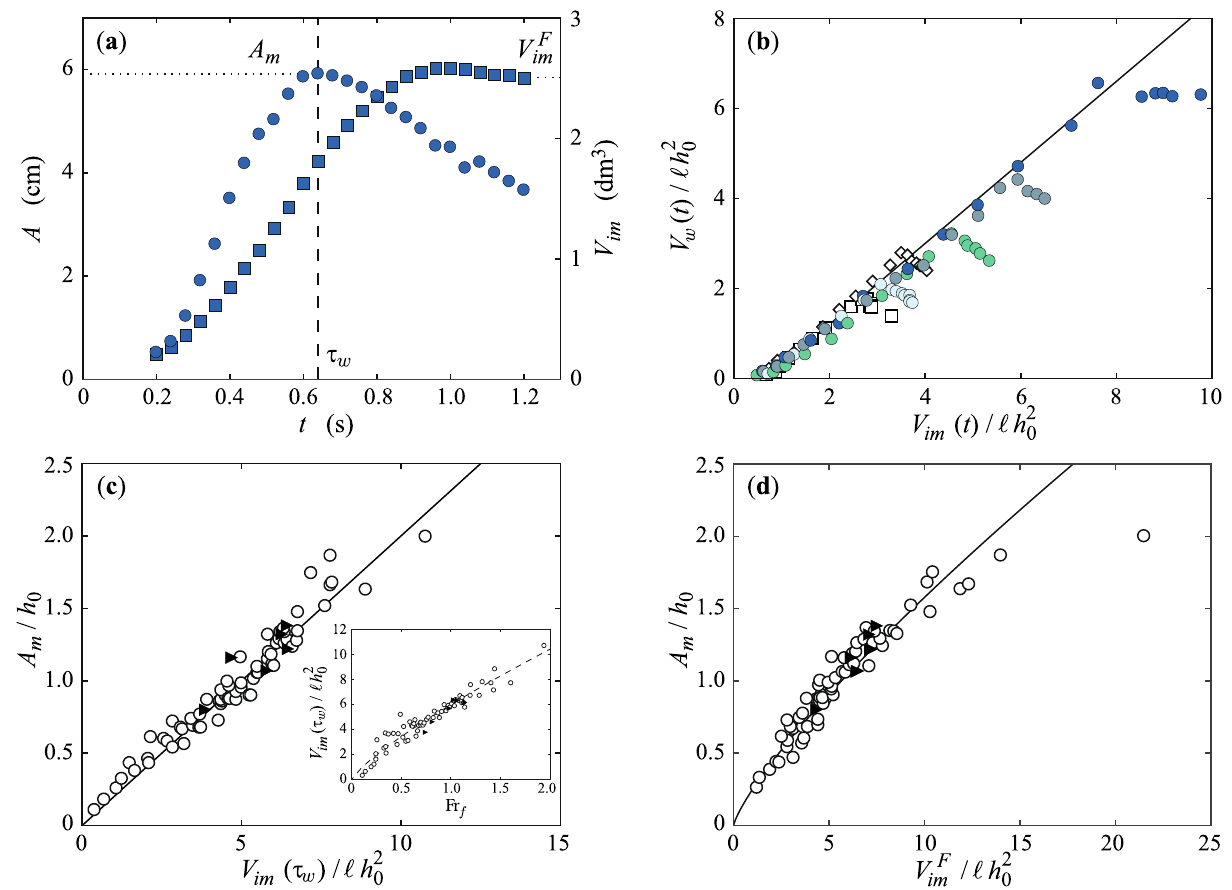
Figure 2. ( a ) Time evolution of ( ) the amplitude A of the impulse wave and of ( ) the volume of grains V im entering into water for the experiment shown in Fig. 1e. The vertical dashed line corresponds to the time τ w 0.65 s at which A reaches its maximal value A m 6 cm in this experiment. ( b ) Instantaneous volume of = ≃ A ( t ) (cid:31) ( t )ℓ , rescaled by ℓ h 2 the impulse wave, V w ( t ) 0 as a function of the instantaneous volume of immersed = 5 cm and grains, V im ( t ) , also rescaled by ℓ h 2 0 , for the experiments shown in Fig. 1c–f with a water depth h 0 = 2.0dm 3 ( ), 3.3 dm 3 ( ), 4.9 dm 3 ( ), and 7.8 dm 3 ( ), and two other experiments a volume of grains V g = 8 cm ( ) and 10 cm ( ). The solid line corresponds to a linear fit of equation 6.2dm 3 and h 0 with V g = = V τ w for of the corresponding rescaled instantaneous volume of immersed grains, V im (τ w )/ℓ h 2 0 , at the time t = all the experiments made either with setup I ( ) or with setup II ( ). The solid line is a linear fit of equation A gh 0 6Fr 0.8 A m / h 0 as a with the same data symbols and (- - -) best fitting power law of equation V im ( t )/ℓ h 2 0 (cid:31) f . ( d ) = function of the rescaled final volume of immersed grains, V F im /ℓ h 2 0 , for all the experiments with the best